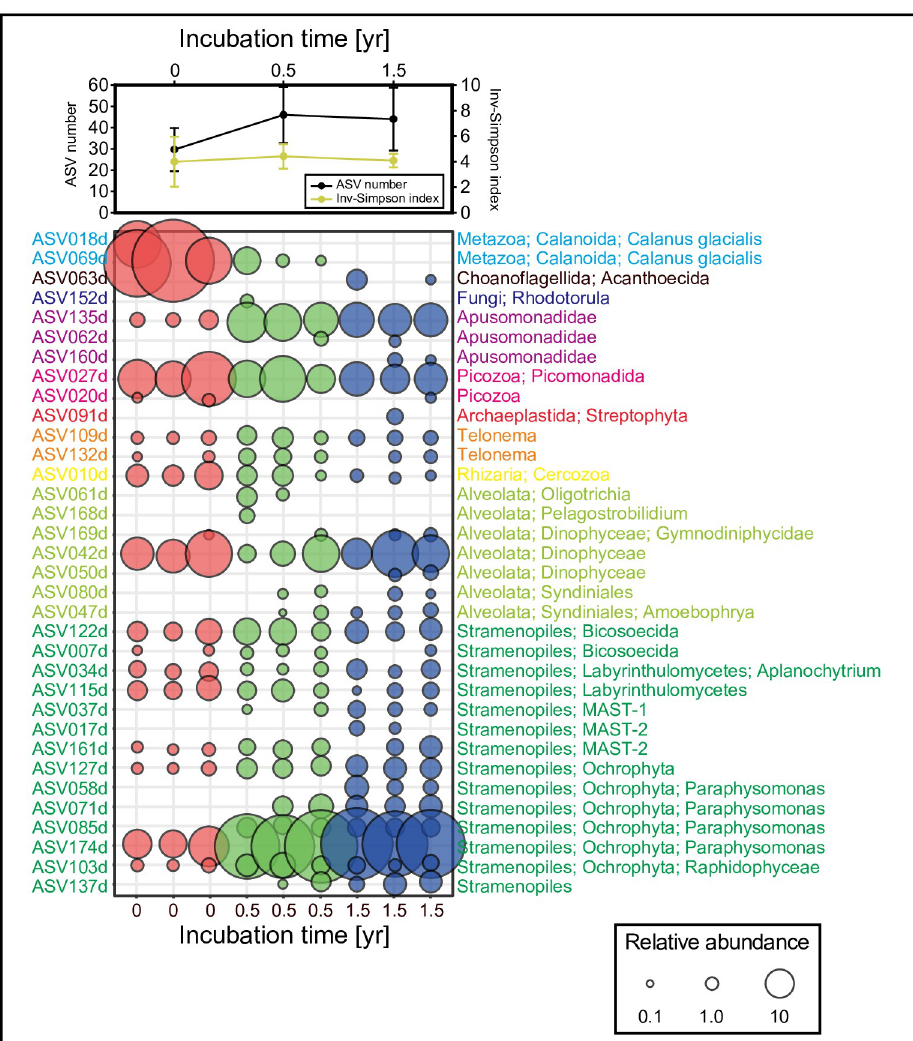
Fig 5. ASV number, Inv-Simpson index, and composition of the eukaryotic community ( � 0.5% of total reads) for sample E for each incubation time. The area of circles is proportional to the relative